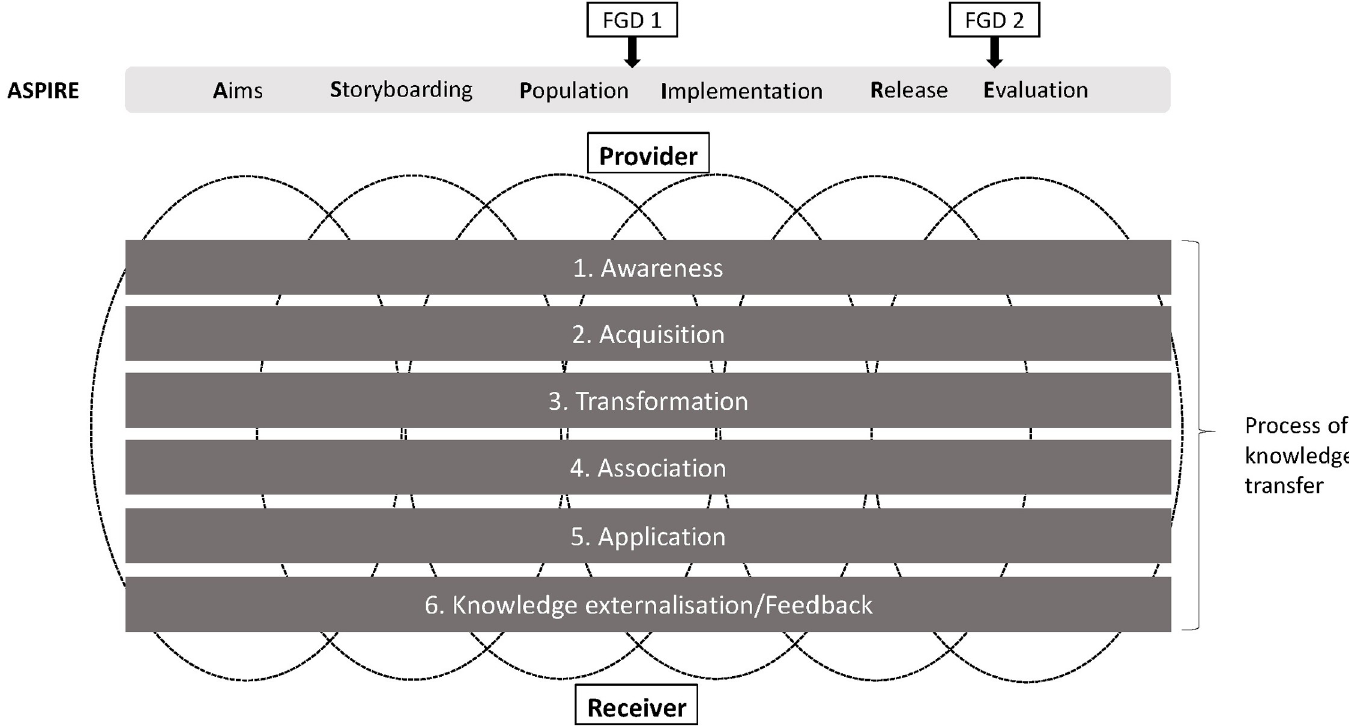
Fig 1. Theoretical framework for knowledge transfer of ASPIRE, a methodology for developing reusable learning objects, between UK/EU (provider) and Malaysian (receiver) universities. Adapted from Liyanage et al. (2009). FGD, focus group discussion.